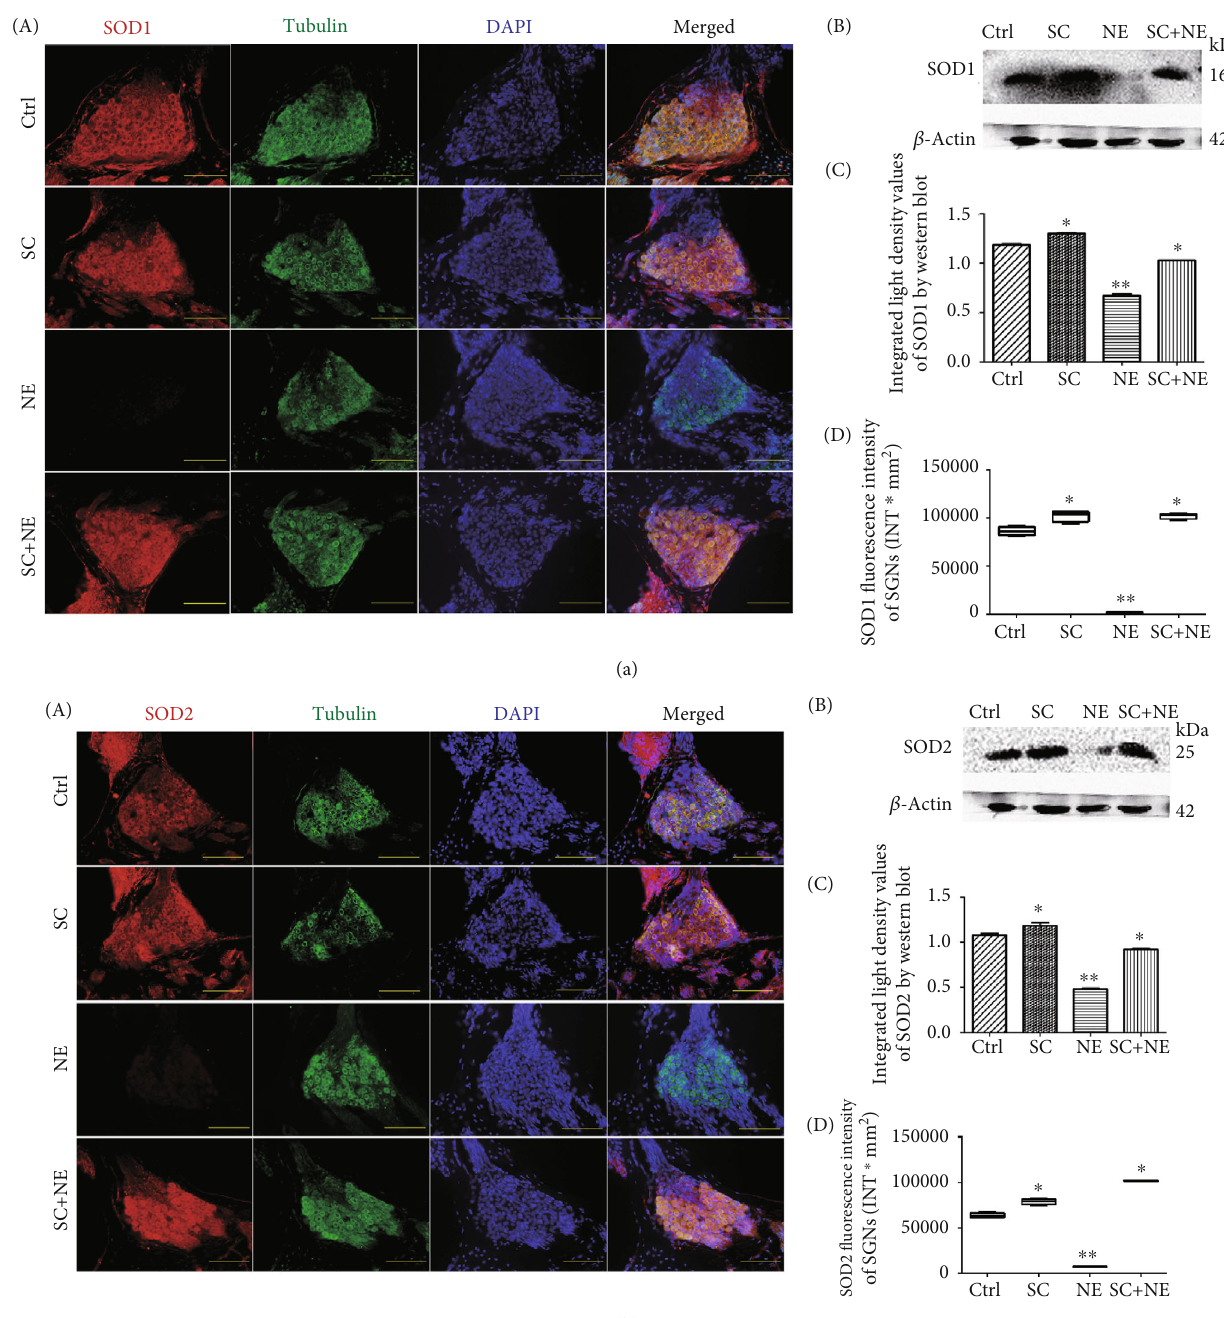
Figure 6: SOD1 and SOD2 protein expressions of SGNs after sound conditioning and acute noise exposure. Distributions and expressions of SOD1 (a) and SOD2 (b) protein were detected with the immune- fl uorescence assay in the Ctrl and SC groups as well as the NE and SC+NE groups (A), while the quantity of these protein expressions was analyzed by fl uorescence intensity (D). SOD1/SOD2 (red) and tubulin (green) as SGN marker were, respectively, labeled with fl uorescent secondary antibody, and nuclei (blue) were labeled with DAPI. Scale bars represent 100 μ m. Protein expressions of these were also assessed with western blot (B), while the quantity of these protein expressions was analyzed by integrated light density (C). β -Actin protein was available as an endogenous control. Furthermore, values are means ± SD ( n = 12 animals/group). ∗ P < 0 : 05 vs. control group; ∗∗ P < 0 : 05 vs. control group. Statistical analysis of the results presented in (C) was performed with one-way ANOVA (SOD1: F = 579 : 5 , P < 0 : 0001 ; SOD2: F = 271 : 3 , P < 0 : 0001 ), followed by Newman-Keuls ’ post hoc test ( ∗ P < 0 : 05 , ∗∗ P < 0 : 05 ; n = 12 animals/group). Statistical analysis of the results presented in (D) was performed with one-way ANOVA (SOD1: F = 1335 : 0 , P < 0 : 0001 ; SOD2: F = 1521 , P < 0 : 0001 ), followed by Newman-Keuls ’ post hoc test ( ∗ P < 0 : 05 , ∗∗ P < 0 : 05 ; n = 6 pictures from 3 animals/group). Furthermore, values are means ± SD